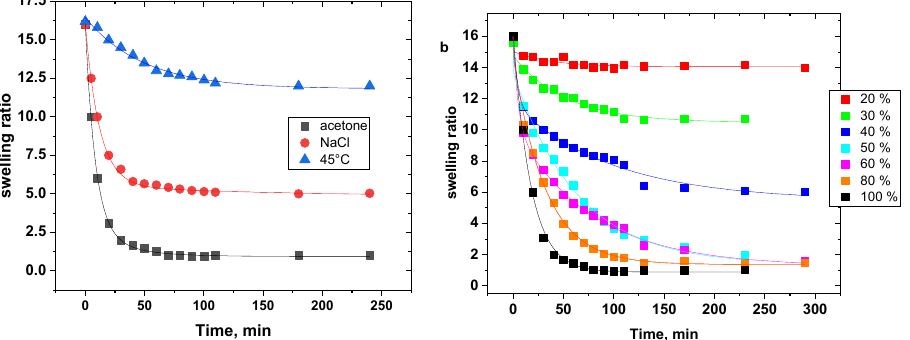
Figure 9. Deswelling kinetic curves: time dependence of the swelling ratio of the DN-DA hydrogel swollen at 25 °C water after immersion in 100 vol.% acetone, 6 M NaCl and pure water at 45 °C ( a ) and after immersion in water–acetone mixtures with various acetone contents ( b ). Experimental points are fitted using Equation (1).